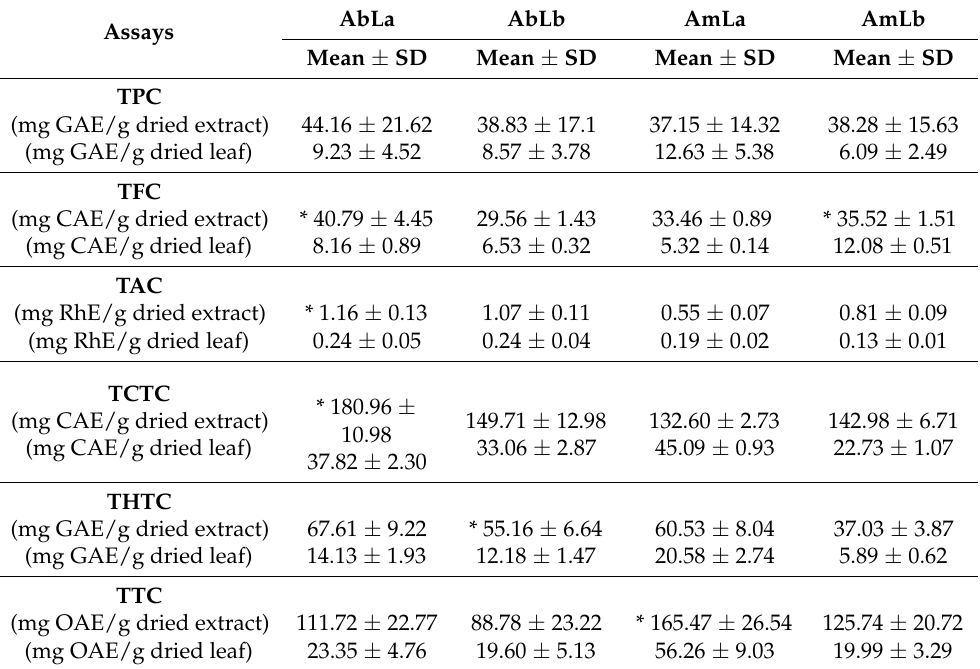
Table 2. Quantification of the principal classes of secondary metabolites of A. bento-rainhae and A. macrocarpus leaf crude